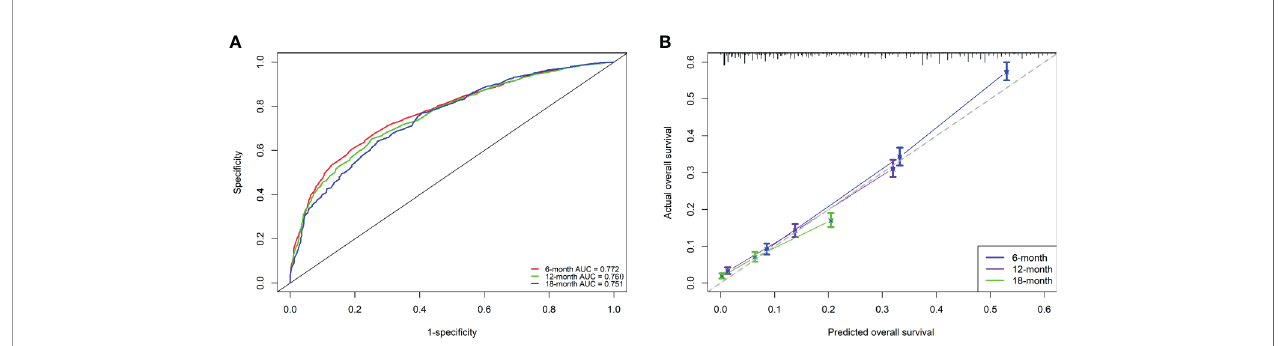
FIGURE 6 | Performance of the nomogram for metastatic pancreatic cancer patients (A, B) . (A) ROC curves and AUC at 6, 12, and 18 months were used to estimate discriminating power of the nomogram. the closer the area under the curve is to 1, the better the distinguishing ability is; (B) Calibration curves for predicting 6-, 12-, and 18-month OS were used to estimate the prediction accuracy of the nomogram. The x -axis indicates the predicted overall survival probability, and the y -axis indicates the actual survival probability. The 45-degree line ( gray line ) indicates that the prediction agrees